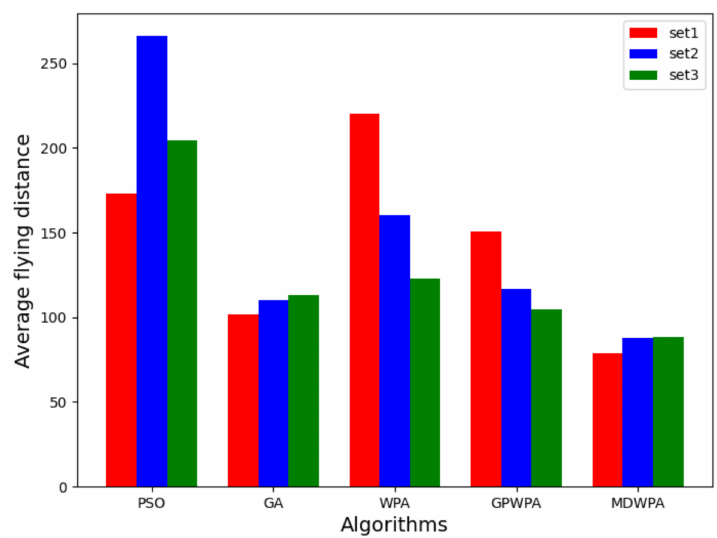
Figure 10. The average flight distance of the UAV in the three example